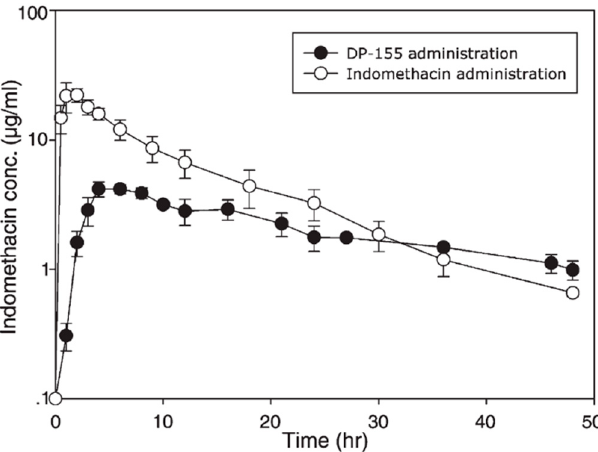
Figure 4. Indomethacin plasma profiles following oral administration of PL-prodrug DP-155 ( ● ) vs. free indomethacin ( ○ ). Reproduced with permission from reference [29], Elsevier, 2007.